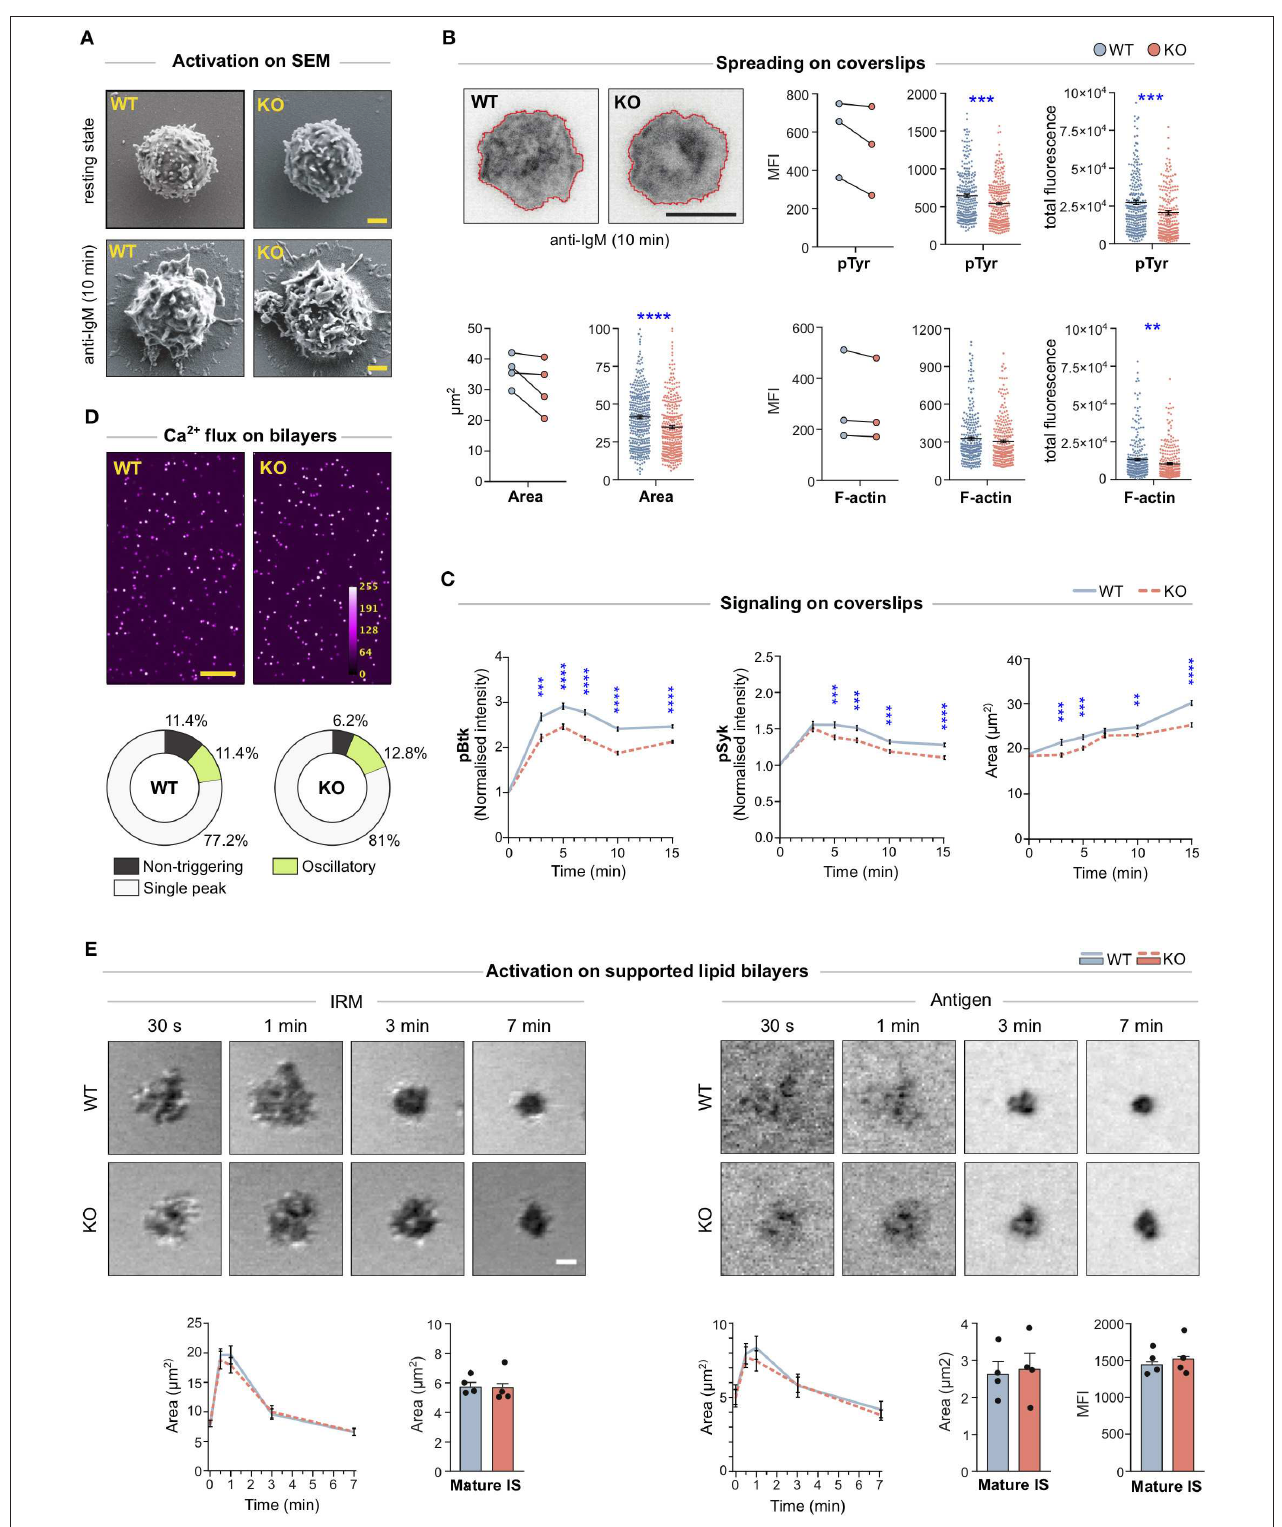
FIGURE 3 | MIM − / − B cells show diminished spreading and signaling on antigen-coated glass, but gather normal levels of antigen on supported lipid bilayers. (A) Scanning electron micrographs of WT and MIM-KO splenic B cells at resting state, let to adhere on CellTak-coated coverslips, or let to spread and get activated